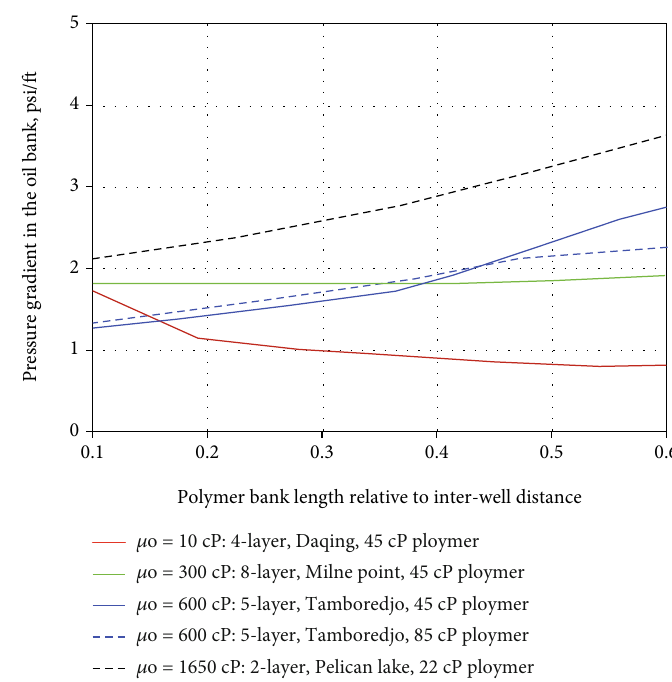
Figure 8: Simulation predicted pressure gradients in the oil bank at various oil fi eld